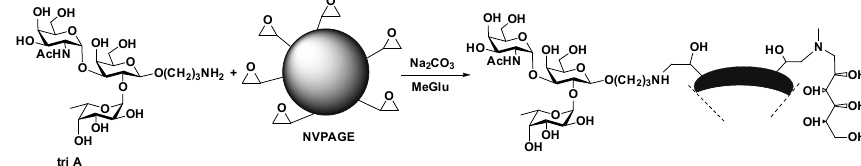
Figure 4. Fragments of the HSQC spectra of the original NVPAGE polymer and the vectorized con- jugate based on it. We also analyzed the signals of the carbohydrate residues in the vectored conjugate. Figure 5 shows fragments of the 1 H NMR spectra of free meglumine and the resulting